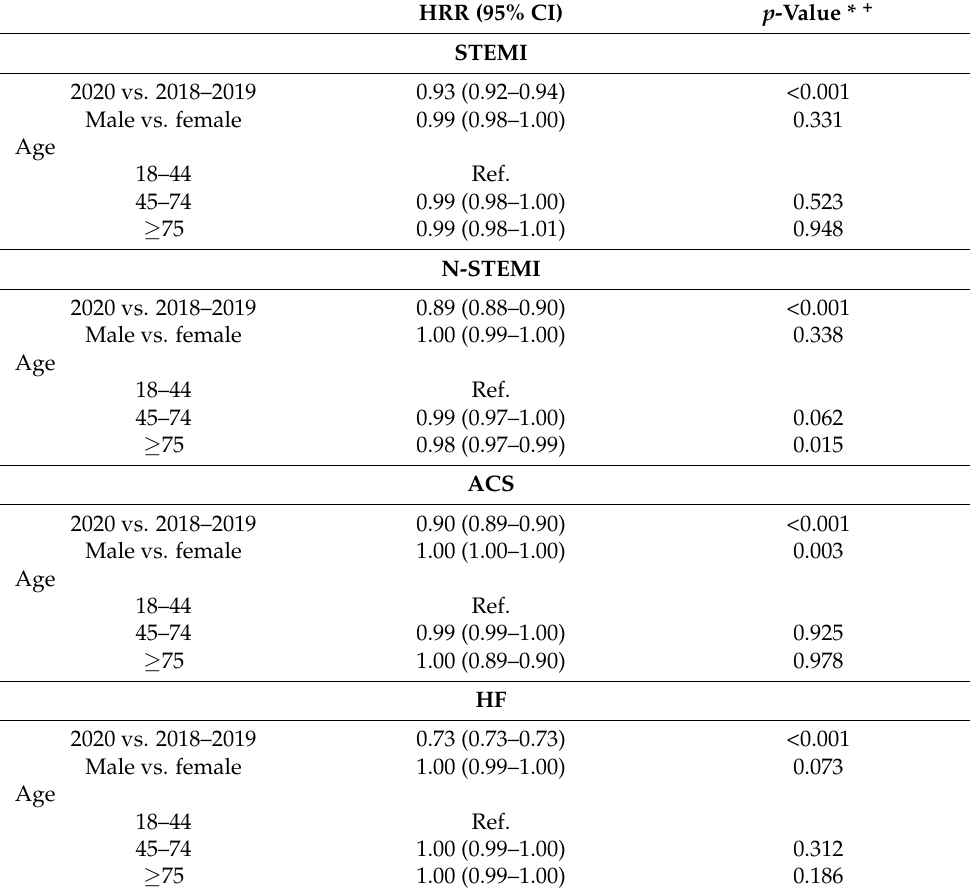
Table 2. Hospitalization rate ratios of CVDs in 2020 compared to the two-year period of 2018–2019. HRR (95% CI) p -Value * +